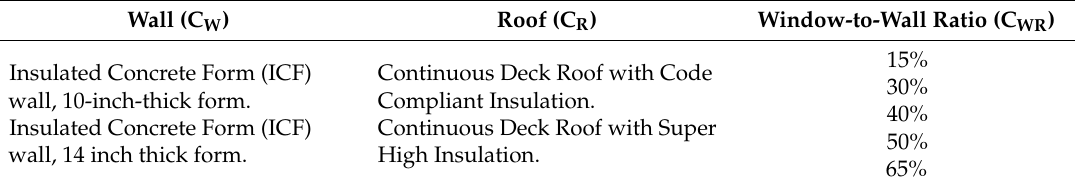
Table 2. The applied alternatives of construction